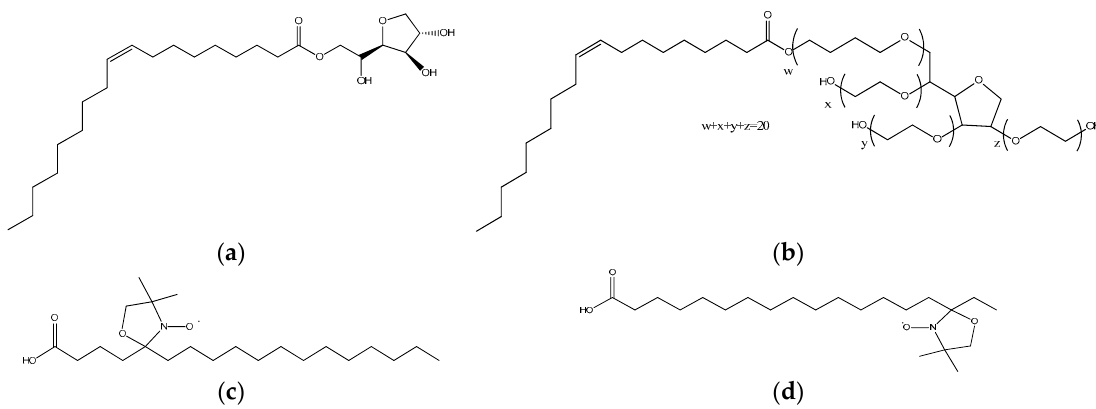
Figure 1. Molecular formulae of ( a ) Span80, ( b ) Tween80, ( c ) 5-doxyl stearic acid (5-DSA) and ( d ) 16-doxyl stearic acid (16-DSA).